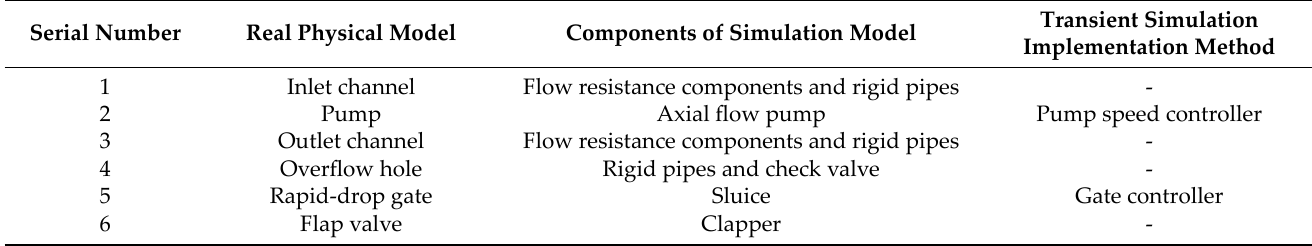
Table 2. Simulation component name.